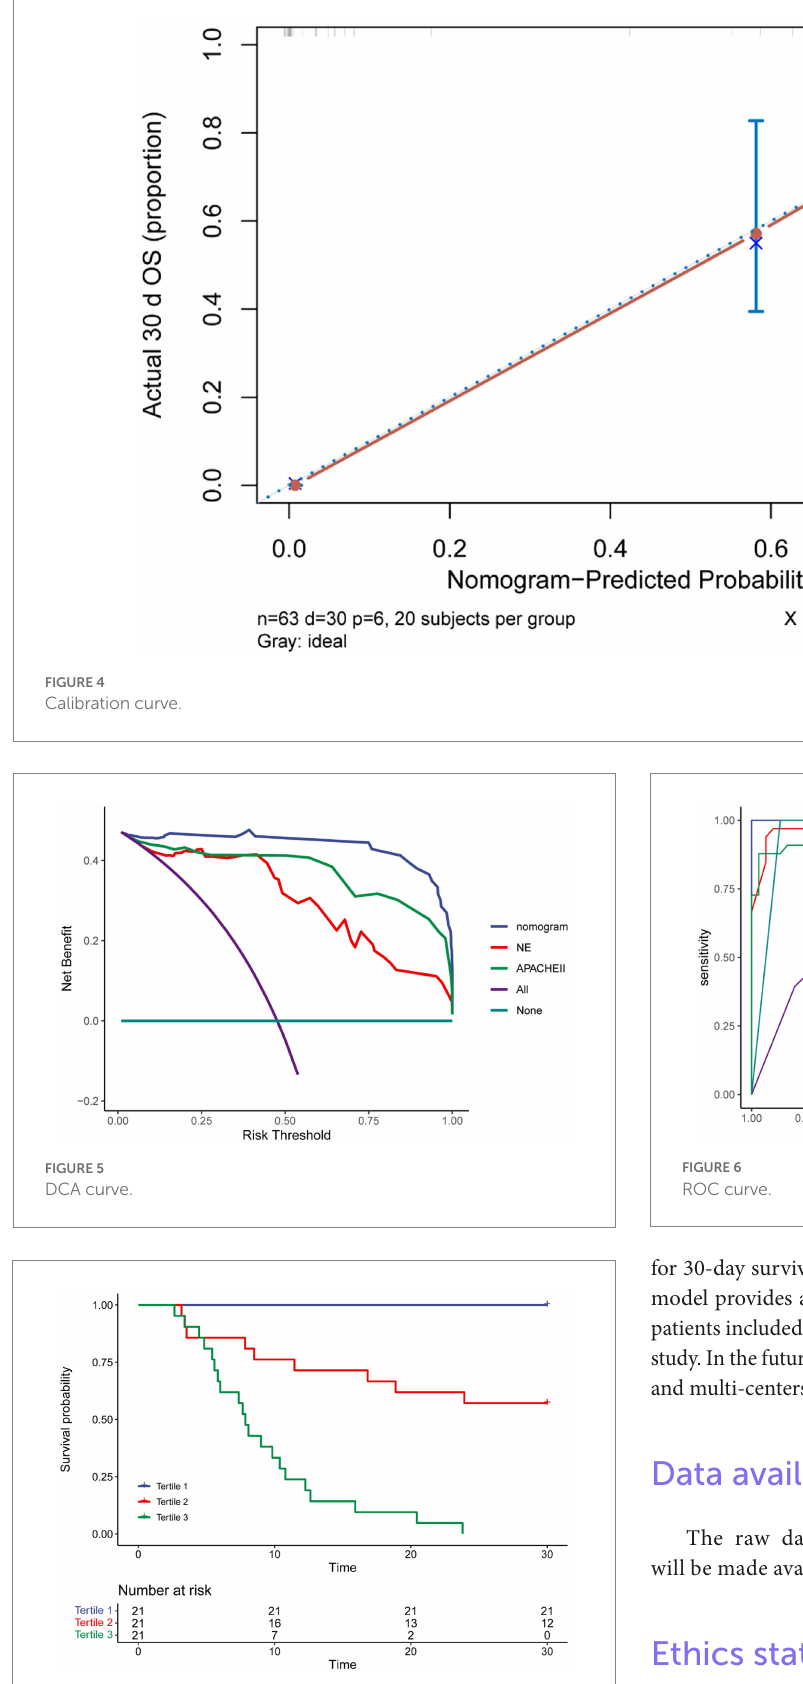
FIGURE 7 Kaplan-Meier curves are stratified by quartiles of predicted